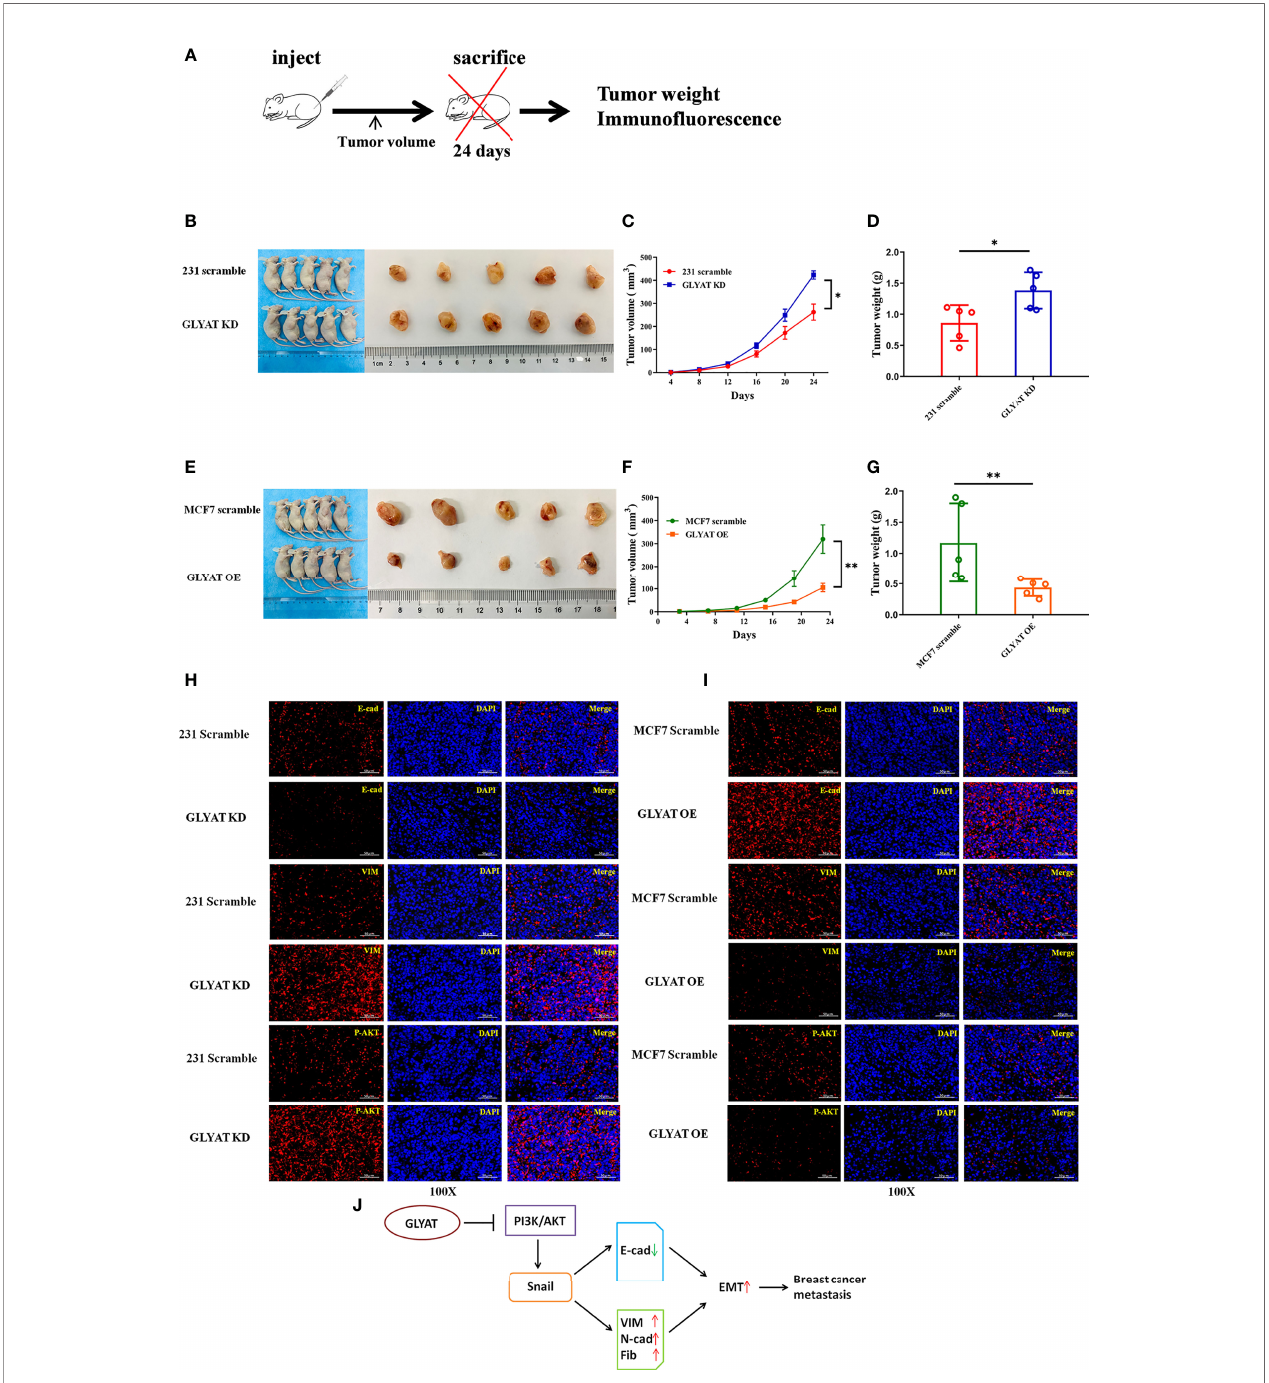
FIGURE 5 | GLYAT suppress breast cancer proliferation, metastasis and EMT in vivo . (A) Schematic diagram of the metastasis model in mice. (B – D) The mice injected with stable GLYAT KD MDA-MB-231 cells had markedly bigger and heavier tumors. (E – G) The mice injected with stable GLYAT OE MCF-7 cells had markedly smaller and lighter tumors. (H) Immuno fl uorescence assay of serial sections mouse tumor tissues revealed that GLYAT KD MDA-MB-231 cells signi fi cantly decreased the expression of E-cadherin whereas increased the expression of Vimentin and p-AKT. (I) Immuno fl uorescence assay of serial sections mouse tumor tissues revealed that, in GLYAT OE MCF-7 cells, the expression of E-cadherin was increased whereas Vimentin and p-AKT were decreased. (J) The schematic diagram of the role of GLYAT in BC. * p < 0.05, ** p < 0.01. Scale bars are 50 m